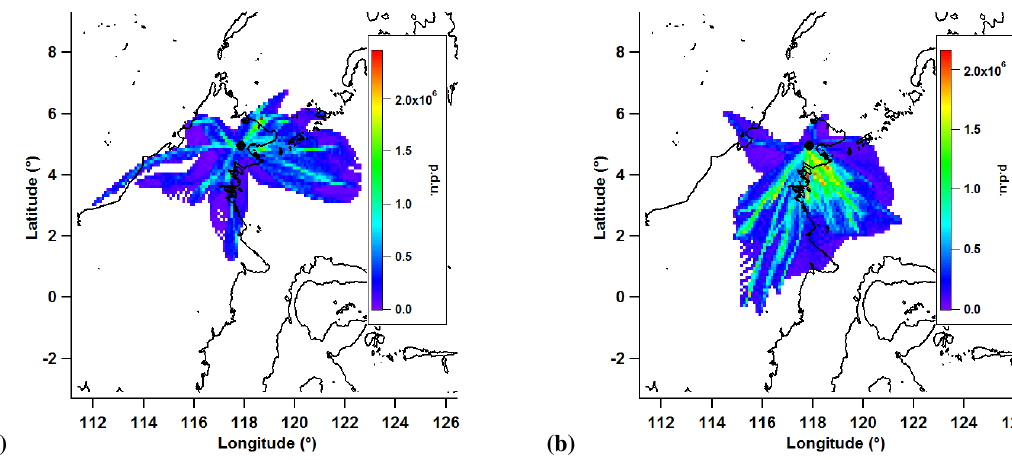
Fig. 1. Residence time of air masses in previous 36h for all trajectories during (a) OP3-I and (b) OP3-III. Colour is number of trajectory data points (normalised to geometric probability density function), expressed in the resulting procedure defined units (p.d.u.). Trajectory receptor site (the measurement site) marked with a black dot.